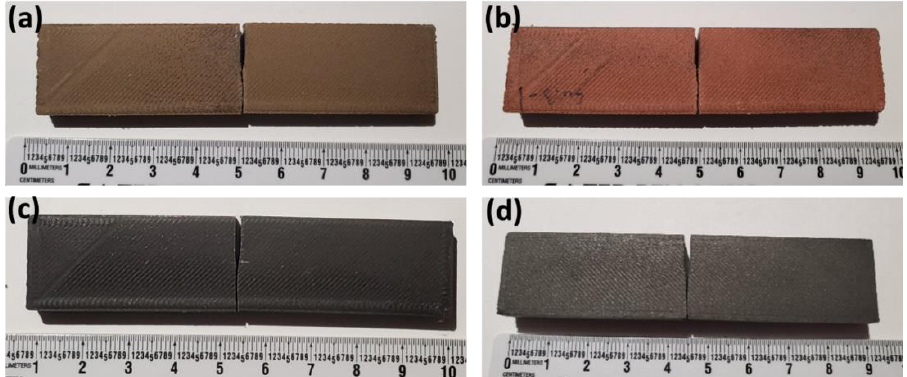
Figure 2. ( a ) Br-PLA, ( b ) Cu-PLA, ( c ), MI-PLA, ( d ) and SS-PLA specimens after undergoing fracture toughness testing.